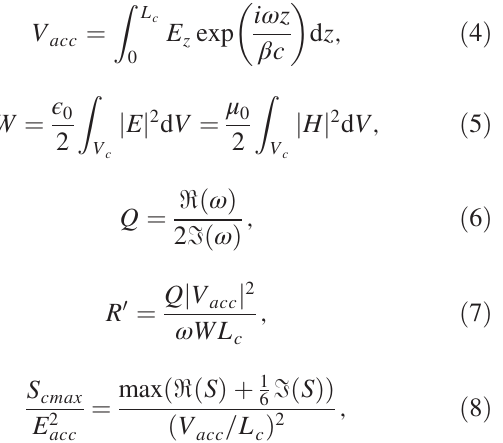
=E 2 and group acc c